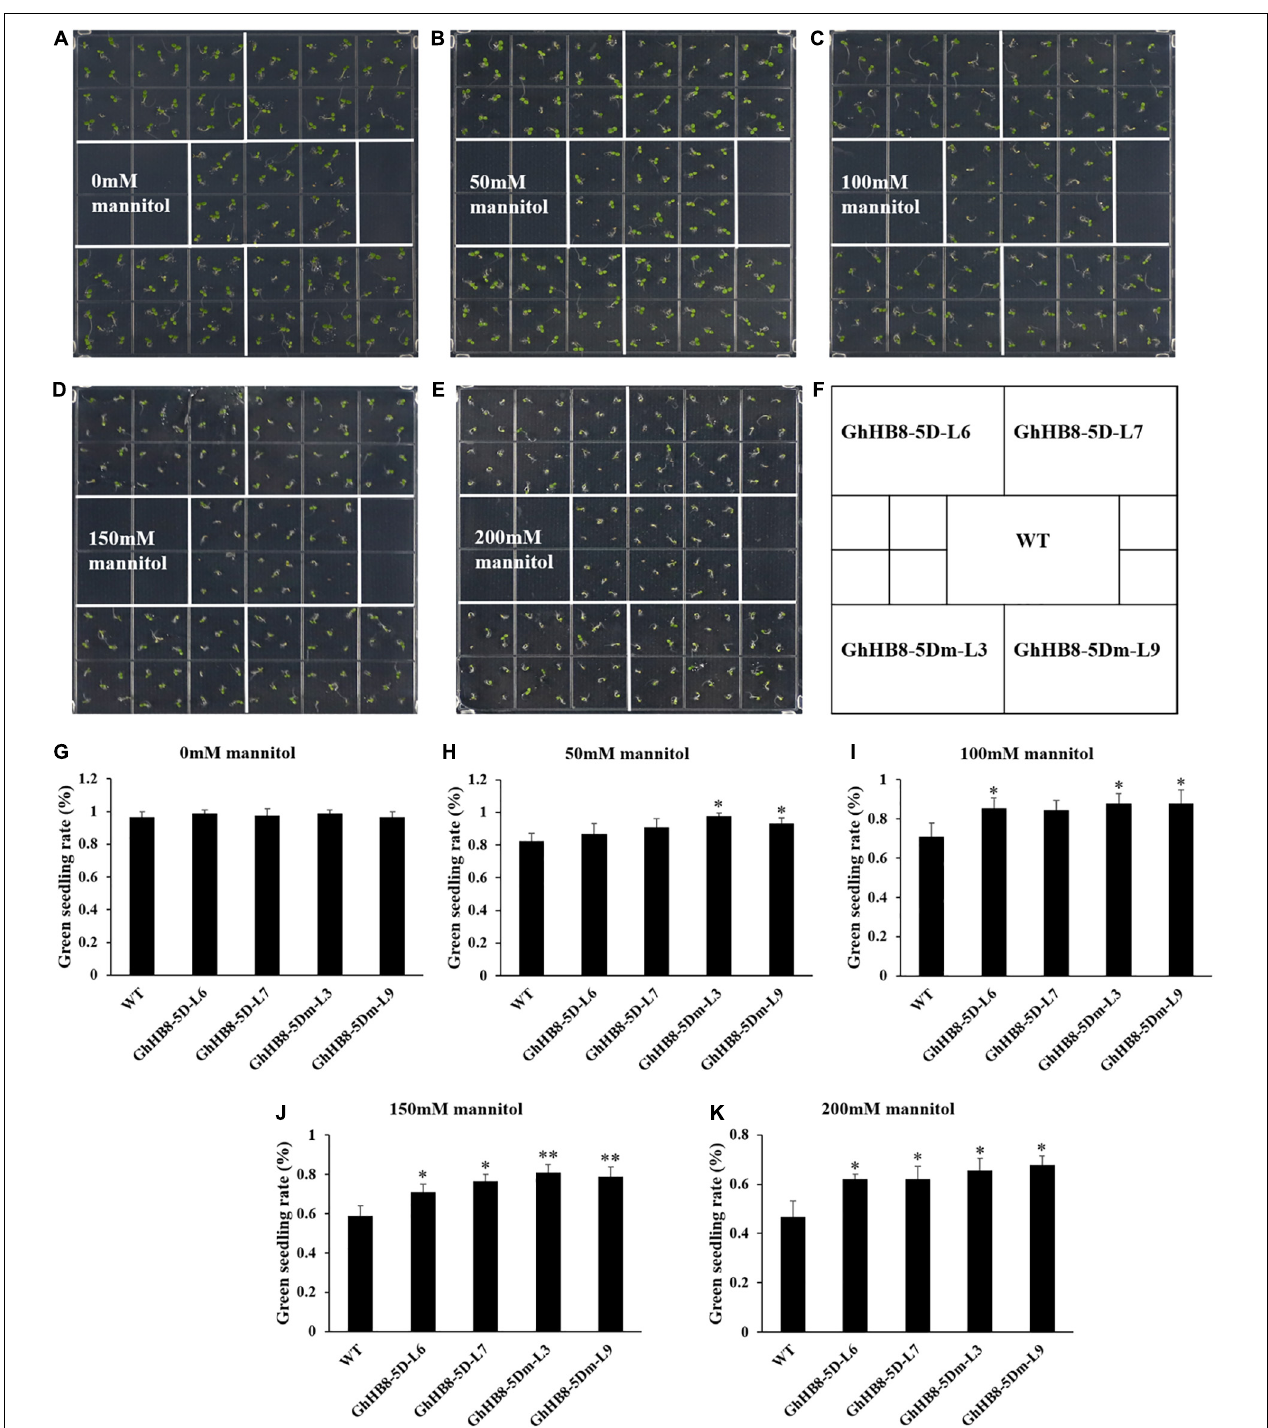
FIGURE 10 | Assay of the green seedling rate of wile type and transgenic lines overexpressing GhHB8-5D and GhHB8-5Dm under mannitol treatment. (A–E) Postgermination green seedling analysis of the wild type and transgenic lines overexpressing GhHB8-5D and GhHB8-5Dm grown on MS medium supplemented with 0, 50, 100, 150, and 200 mM mannitol for 4 days. (F) Schematic diagram of wild type and transgenic seedlings distribution on the MS medium. (G–K) Statistical analysis of the green seedling rate of wild type and transgenic seedlings grown on MS medium containing 0, 50, 100, 150, and 200 mM mannitol for 4 days. Mean values and SD are shown from three biological replicates. Independent t -tests demonstrate that there are significant ( p < 0.05) or very significant ( p < 0.01) differences in green seedling rate between wild type and transgenic lines. *means significant differences ( p < 0.05); **means very significant differences ( p < 0.01).